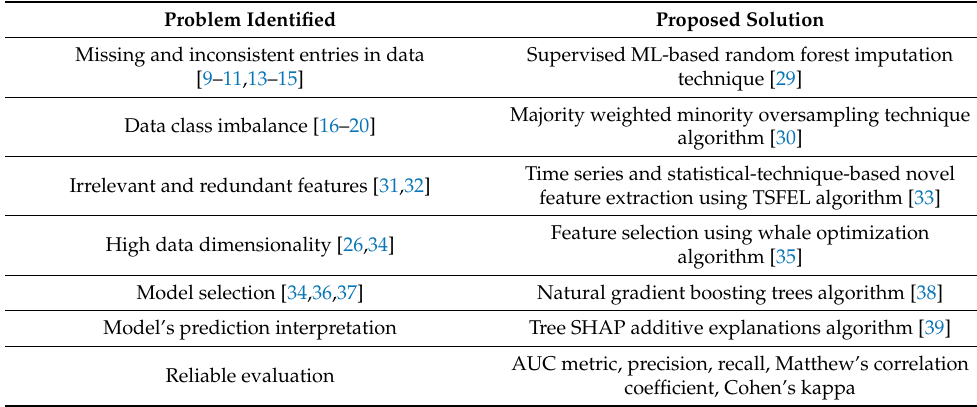
Table 1. Problems identified and the proposed solutions.